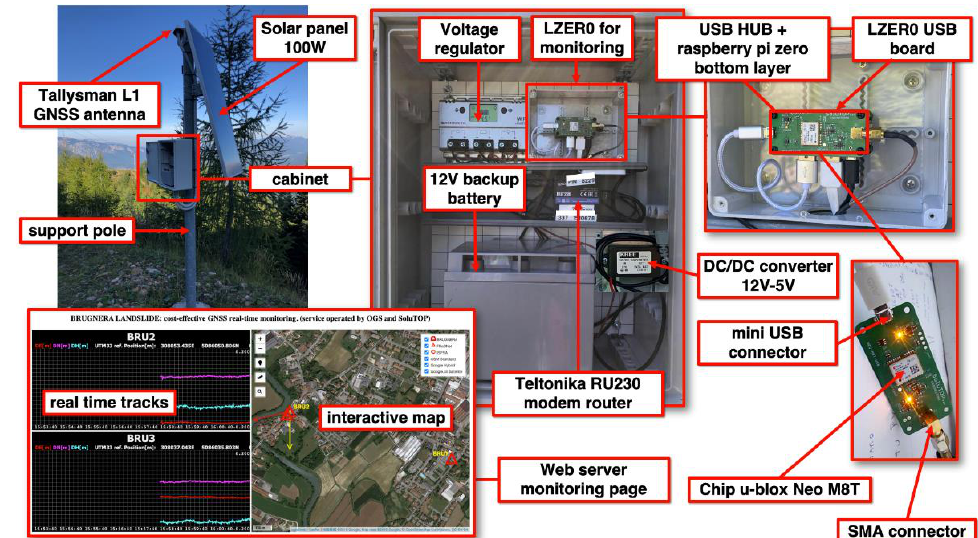
Figure 5. Upper-left corner inset: a typical LZER0 site for a monitoring application. The LZER0 equipment is housed in the cabinet and powered by a solar panel. The LZER0 GNSS antenna is mounted on top of the support mast and is well-anchored to the ground. Top-center picture: contents of the cabinet, including the voltage regulator, backup battery, and LZER0 equipment. Top-right image: the components (mainly the GNSS chipset and the Raspberry Pi Zero SBC) of the LZER0 node. Bottom-right inset: the LZER0 USB board designed by OGS to use the M8T u-blox chipset. On this board, the M8T chip collects the raw GNSS signal from the GNSS antenna connected to the SMA connector and provides the tracked information to the Raspberry Pi SBC USB via the mini-USB connector. Bottom-left: the web page running on the remote server and accessible through an Internet browser. The web page contains, on the left side, the real-time traces of displacements in north – south (NS), east – west (EW), and vertical (UP) directions of each LZER0 node. A map of the LZER0 nodes is shown on the right side of the web page. For each LZER0 node, the horizontal velocities, composed of the NS and EW components (red arrows), and the vertical velocities (yellow arrows), based on the rate of change in the displacement time series, are available. The map is interactive, allowing users to zoom, overlay different background terrain maps, and measure distances and areas.